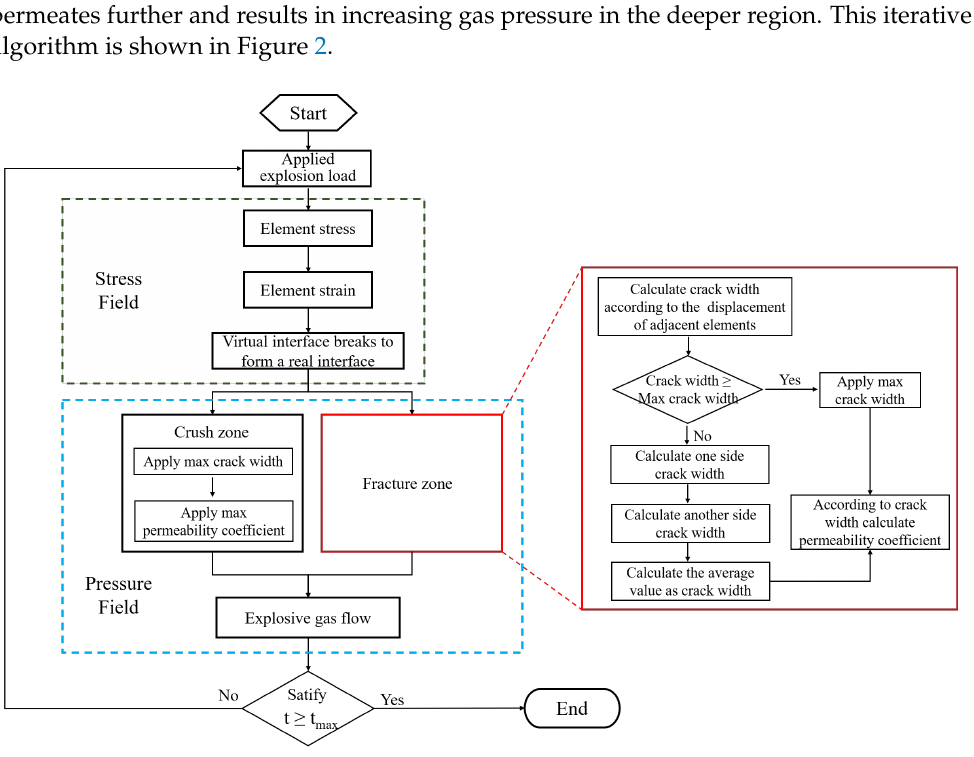
Figure 2. The iterative procedure for calculating the coupled deformation/pressure fields of cracked rock